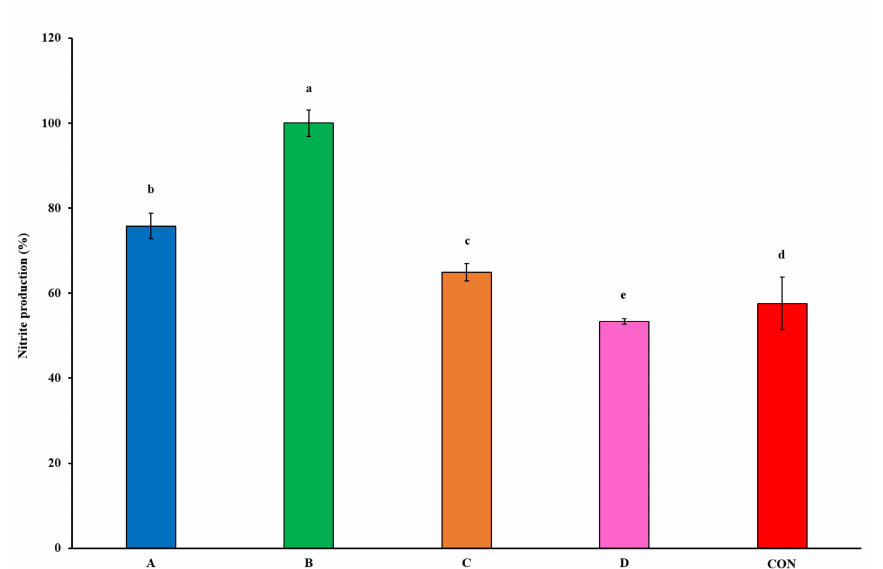
Figure 8. NO production in C2C12 myotubes. Lowercase letters in the same column indicate significant differences according to Duncan’s multiple range tests ( p <